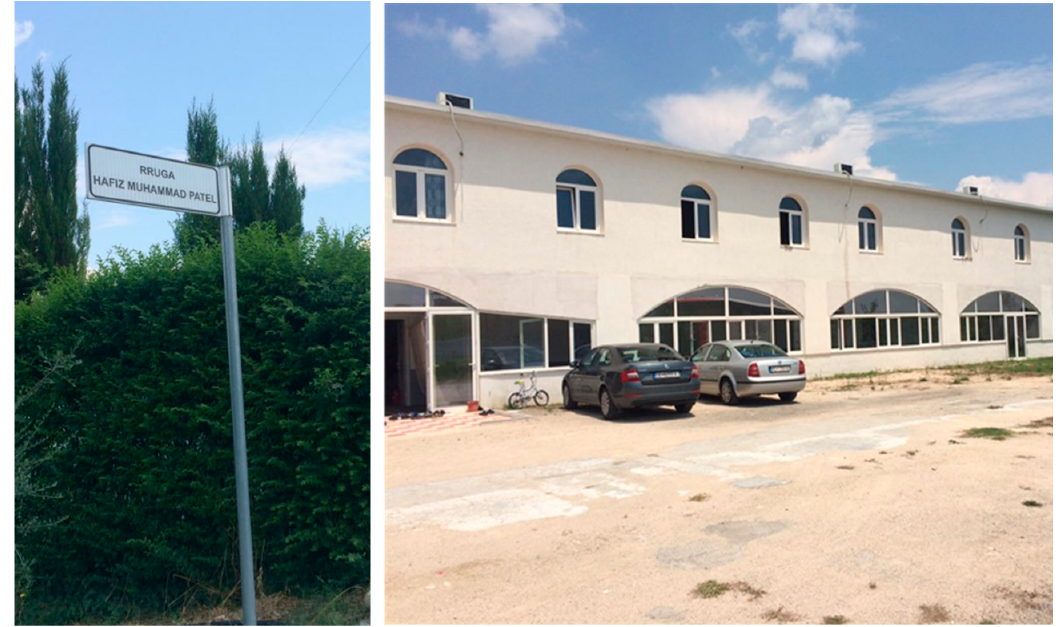
Figure 3. “Earlier today our convoy led by Mufti Muhammad Taqi Usmani and Mufti Ahmed Khanpuri arrived at Tirana Markaz, Albania. The road leading to the Markaz is named after Marhum [Deceased] Hafiz Patel, reflecting his lifelong commitment and dedication to propagating Deen [Religion].” Tweeted by (Mufti) Yusuf ibn (Mufti) Shabbir on 22 June 2018. Source: https://twitter.com/ibn_shabbir/status/1010196457125707776 (accessed on 21 June 2019).